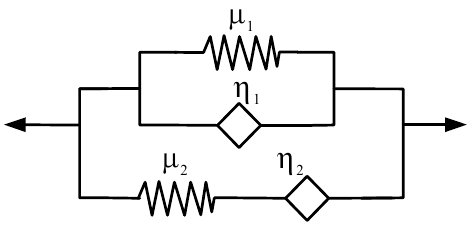
Figure 7. The higher-order fractional derivative model.